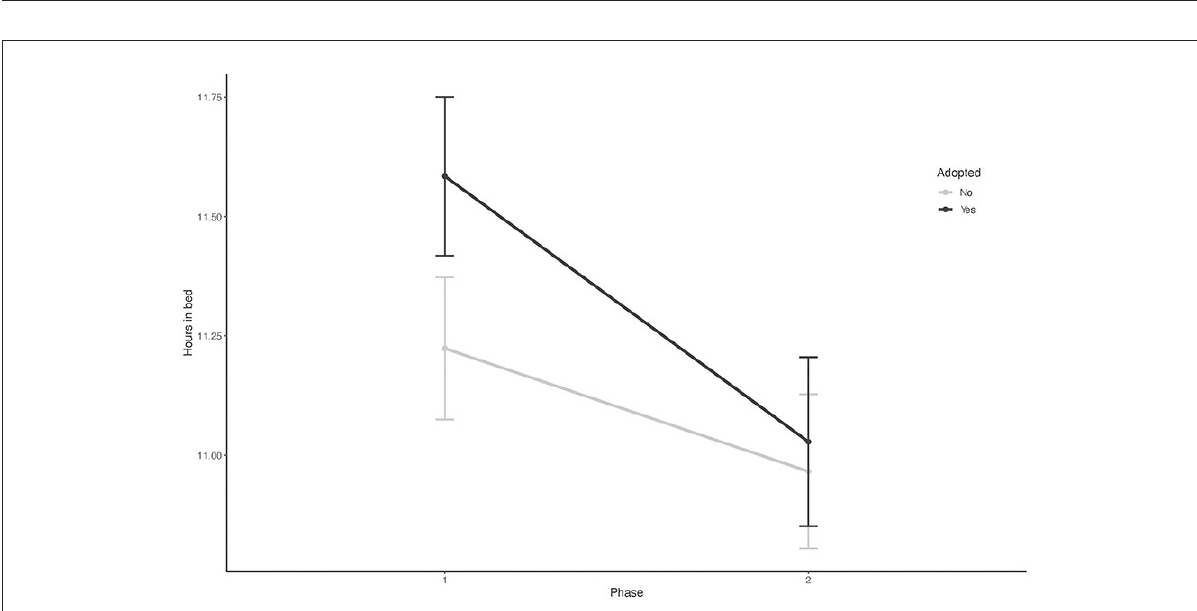
FIGURE2 The mean time spent in bed in 24h in both study groups over two study phases (Phase 1 and Phase